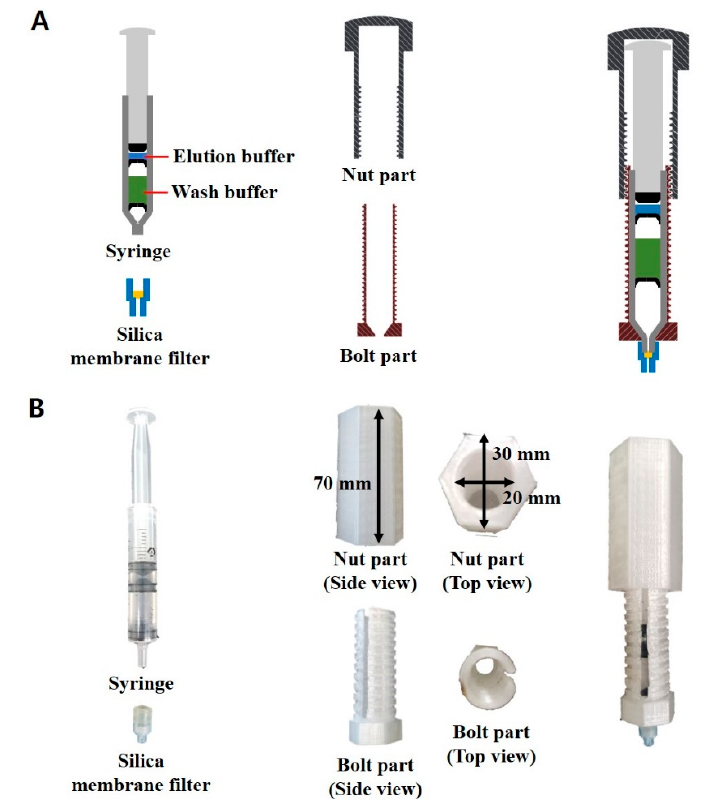
Figure 1. Syringe-based one-step DNA extraction device. ( A ) Schematic illustration of each compo- nent of the syringe-based DNA extraction device. The elution buffer and wash buffer fill the syringe, compartmentalized with the inverted bowl-shaped rubber packing. ( B ) Photographs of each com- ponent of the syringe-based DNA extraction device.